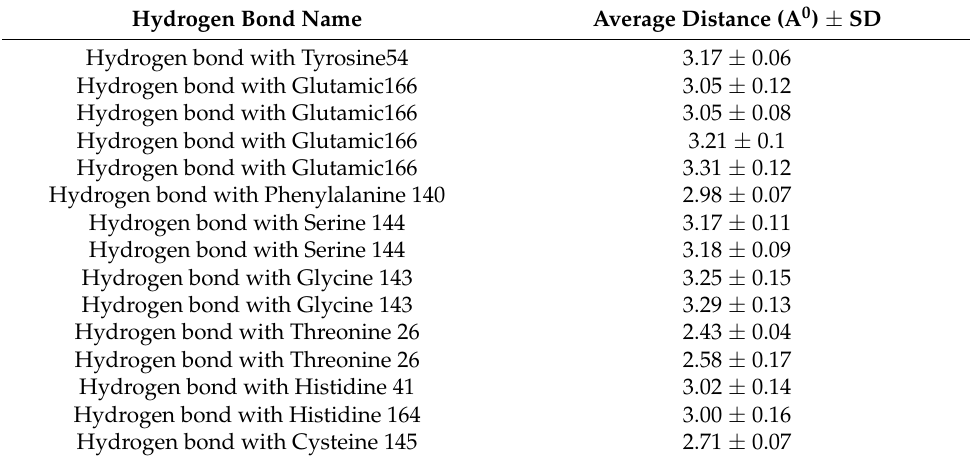
Table 1. The average distances of all hydrogen bonds formed between RMH148 and COVID-19 Mpro through the entire 150 ns MD simulation.